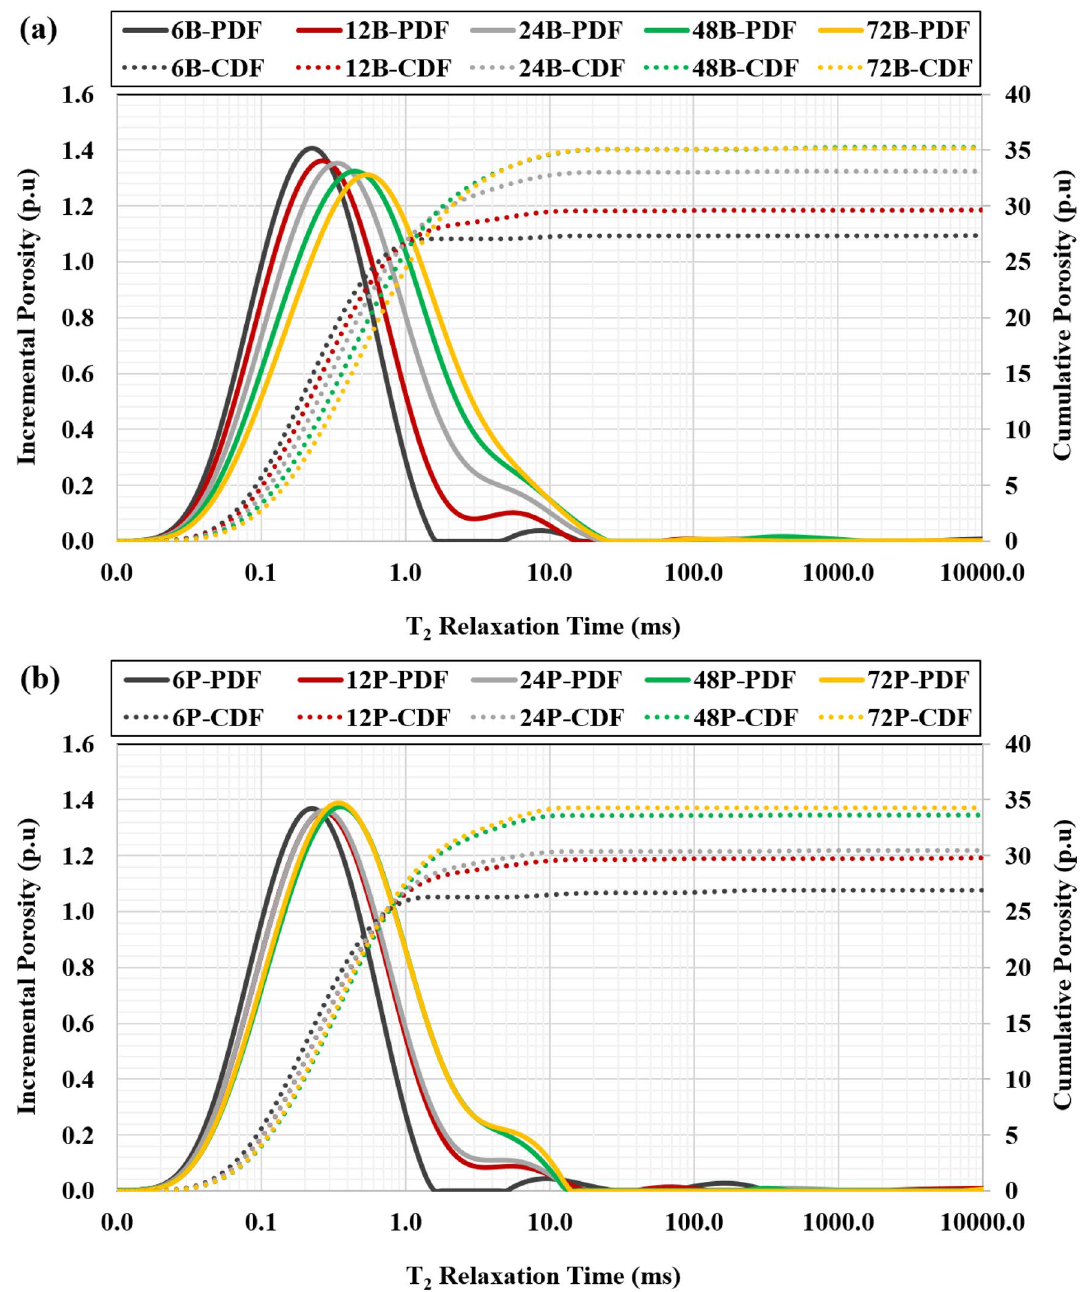
Fig. 8 NMR T 2 relaxation for a neat cement specimens and b polypropylene specimens, after 6, 12, 24, 48, and 72 h of